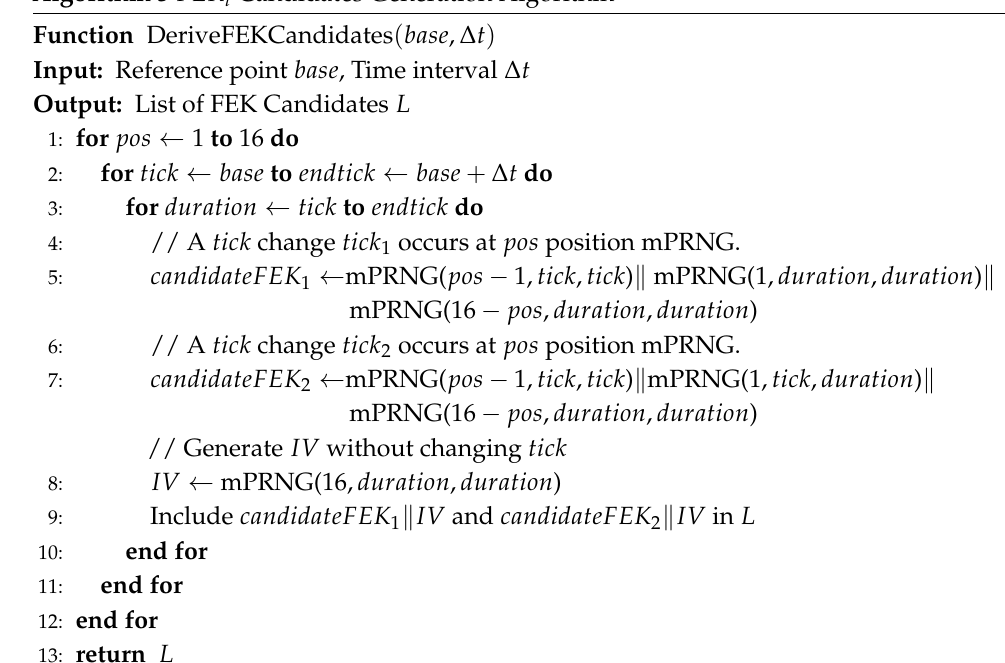
Algorithm 3 FEK i Candidates Generation